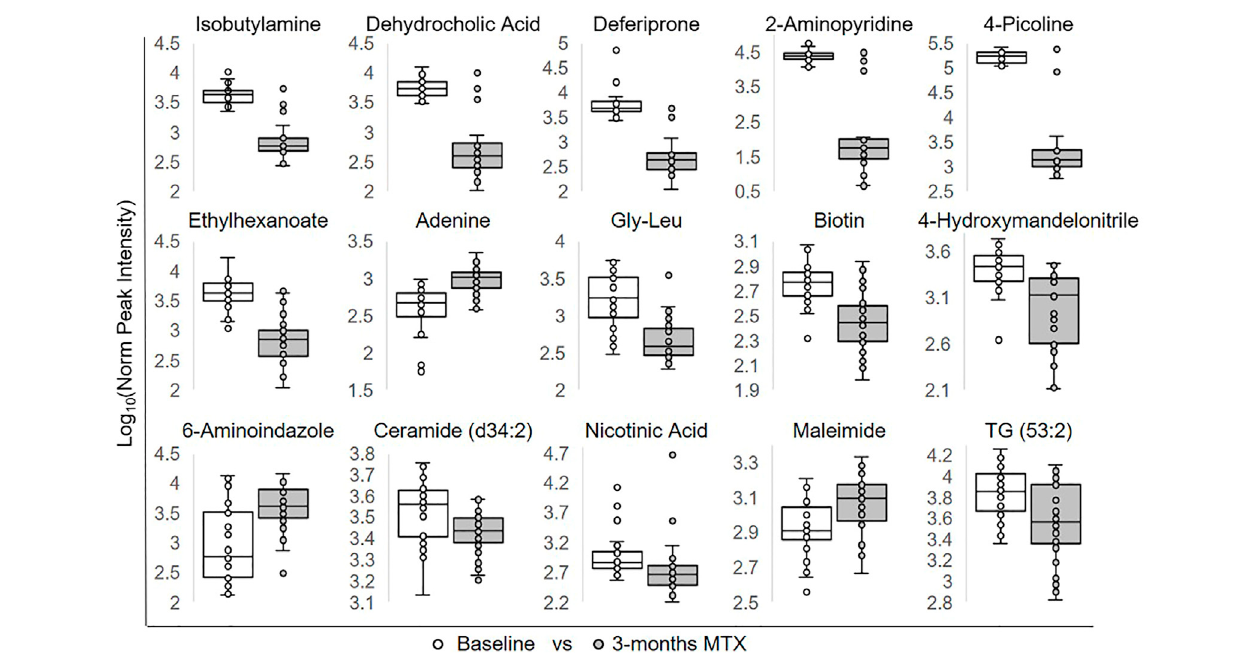
FIGURE 3 | Relative plasma levels of metabolites signi fi cantly altered following the initiation of MTX. The log normalized peak ion intensity plots for the eight metabolitesidenti fi edbyunivariateanalysesarepresented.Datapointsandrepresentativeboxandwhiskerplotsareshownbasedonmetabolomicsanalysisatbaseline and following the 3-months MTX treatment period. Log normalized peak ion intensities were compared between groups using paired non-parametric analysis with unequal variances.